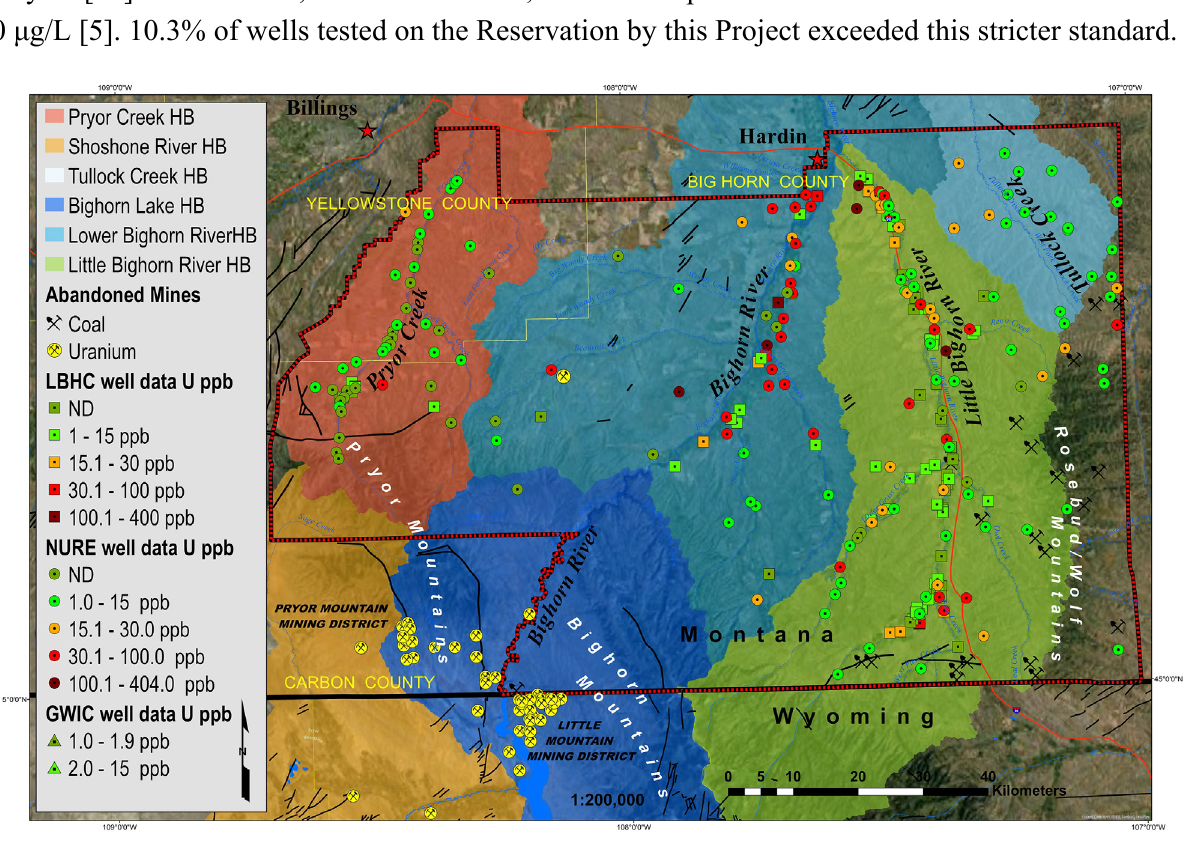
Figure 6. Geographic information system (GIS) generated map showing hydrologic drainage basin units, old uranium mines (yellow dots) and well water data from the United States Geological Survey (USGS) National Uranium Resource Evaluation (NURE) Hydrogeochemical and Stream Sediment Reconnaissance (HSSR) data base; the Montana Bureau of Mines and Geology Ground Water Information Center (GWIC) data base and the Crow Water Quality Project data